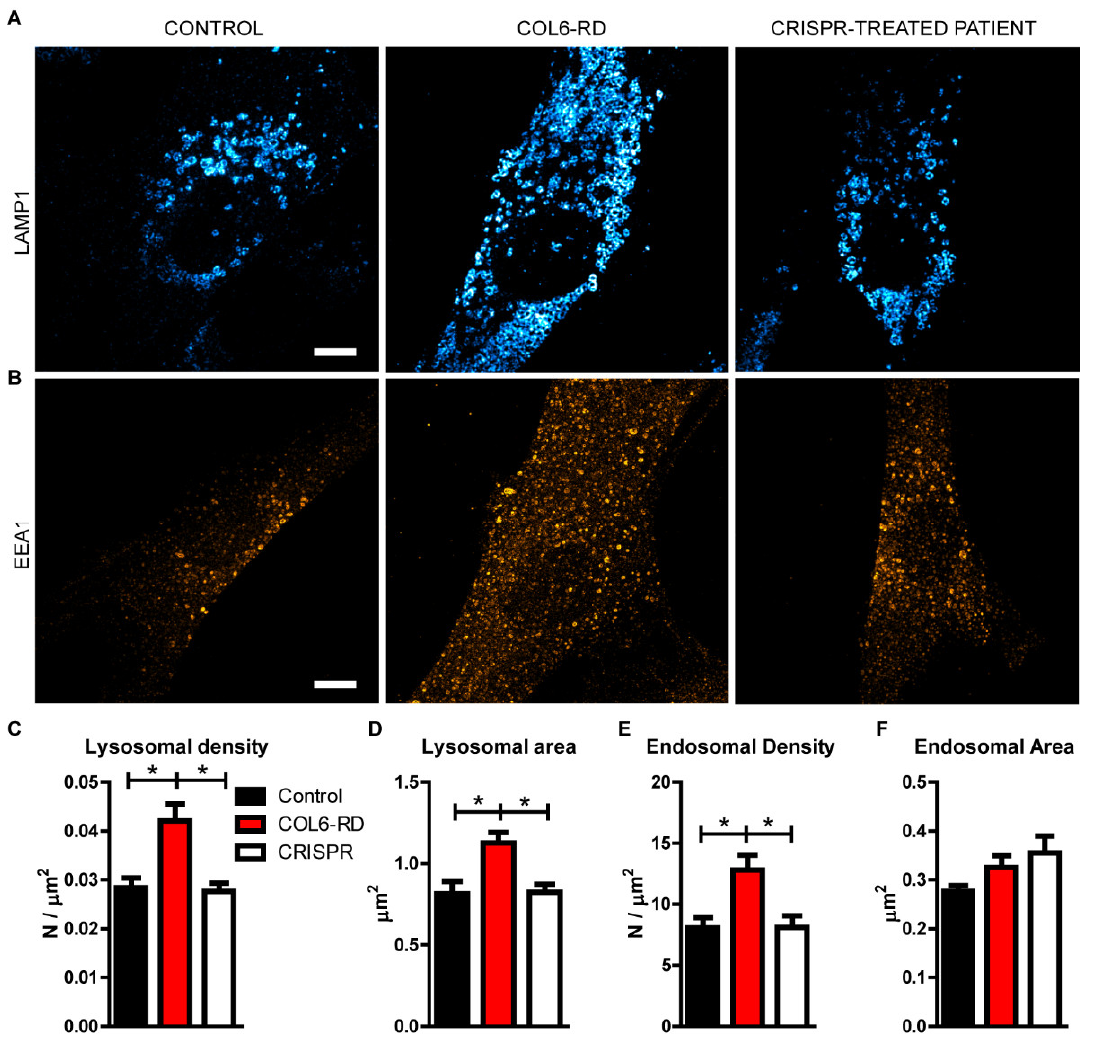
Figure 3. The endo-lysosomal compartments are altered in COL6-RD patient-derived fibroblasts. ( A ) Representative STED images of Lamp1- and ( B ) EEA1-positive organelles labelled in control- and COL6-RD patient-derived fibroblasts and in CRISPR-treated COL6-RD patient-derived fibroblasts. ( C ) Lamp1- and ( E ) EEA1-positive organelles density, together with the area of ( D ) Lamp1- and ( F ) EEA1-positive organelles was quantified. Data are expressed as the mean ± SEM; n = 3; independent primary cell preparations were used for all panels. * p < 0.05; one-way ANOVA/Bonferroni’s multiple comparison test. Scale bar 5 µm.